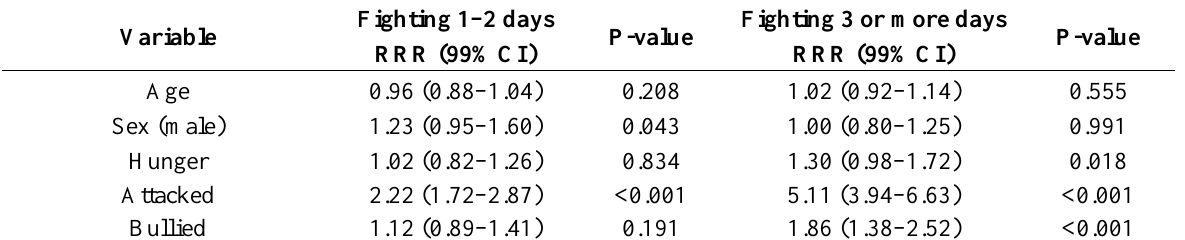
Table 2. Multinomial regression analyses of selected variables examined simultaneously according to fighting category among school-attending adolescents in Ghana